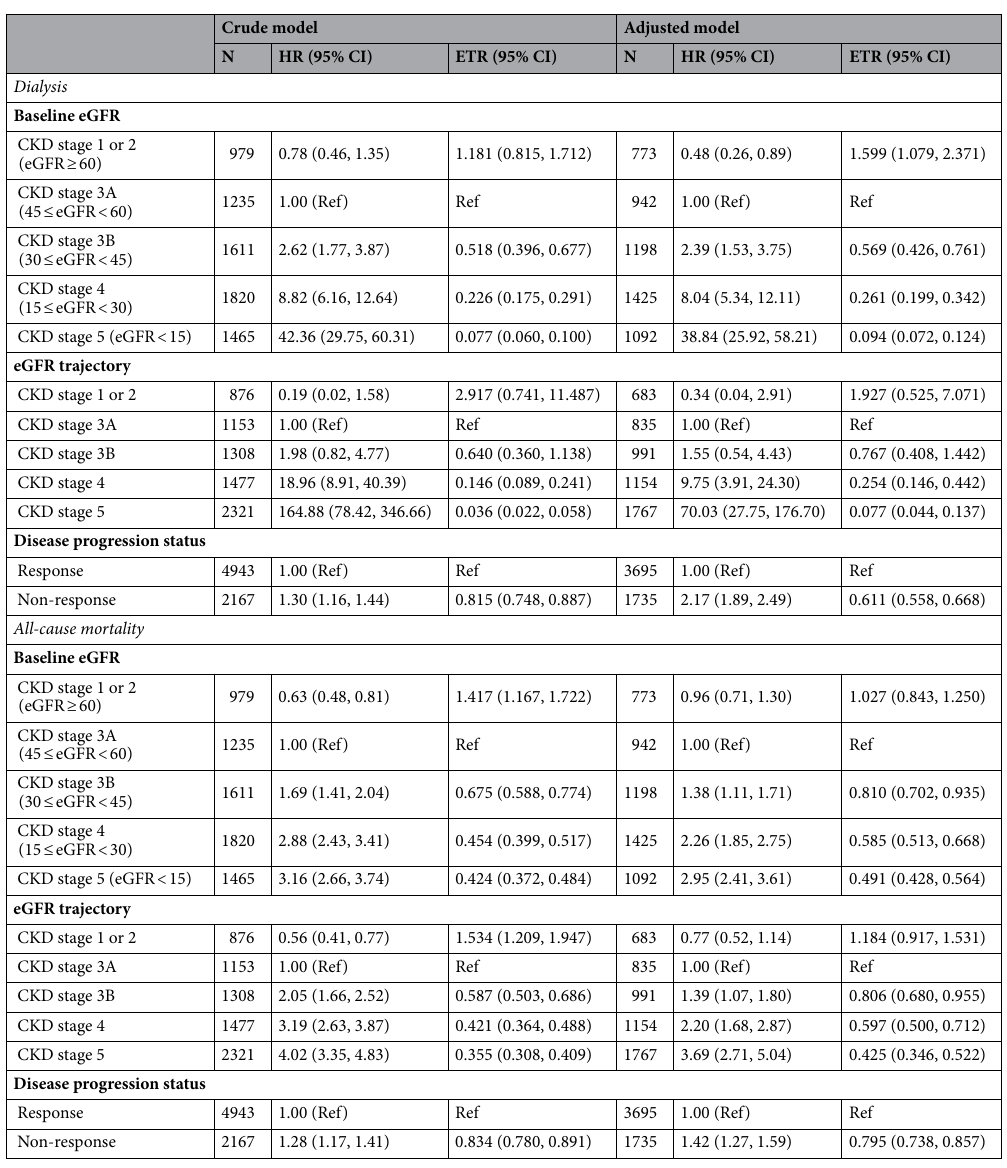
Table 3. HRs (95% CIs) and event time ratio (ETRs, 95% CIs) of the risk of progression to ESRD and all-cause mortality based on trajectories and responsiveness (parametric survival modeling under Weibull regression). Adjusted model: adjusted for age at entry, gender, BMI, smoking status, alcohol consumption, education, diabetes, hypertension, cardiovascular disease, baseline medication for NSAIDs, anti-platelet agents, urate- lowering agents, ACEIs/ARBs, Diuretics, baseline biochemical parameters for pooled urine PCR, and eGFR. ACEI angiotensin-converting-enzyme in inhibitors, ARBs angiotensin receptor blockers, BMI body mass index, CI confidence interval, CKD chronic kidney disease, eGFR estimated glomerular filtration rate, ETR event time ratio, ESRD end stage renal disease, HR hazard ratio, IQR inter-quartile range, NSAID nonsteroidal anti-inflammatory drugs, PCR protein/creatinine